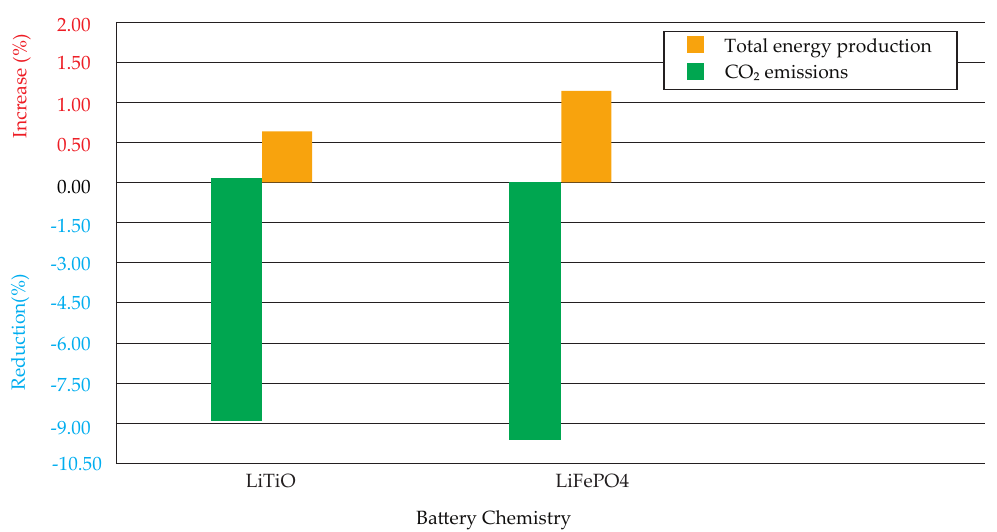
Figure 13. Variation of CO 2 emissions and total energy production using Lithium Titanate (LiTiO) and Lithium Iron Phosphate (LiFePO4) batteries in a 20 ft